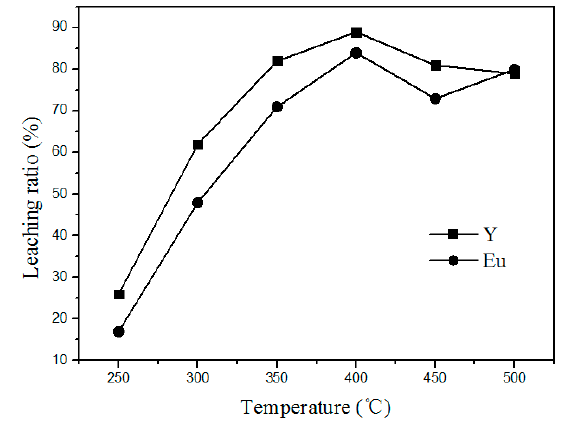
Figure 4. Effect of roasting temperature on the leaching rate of the rare earths.